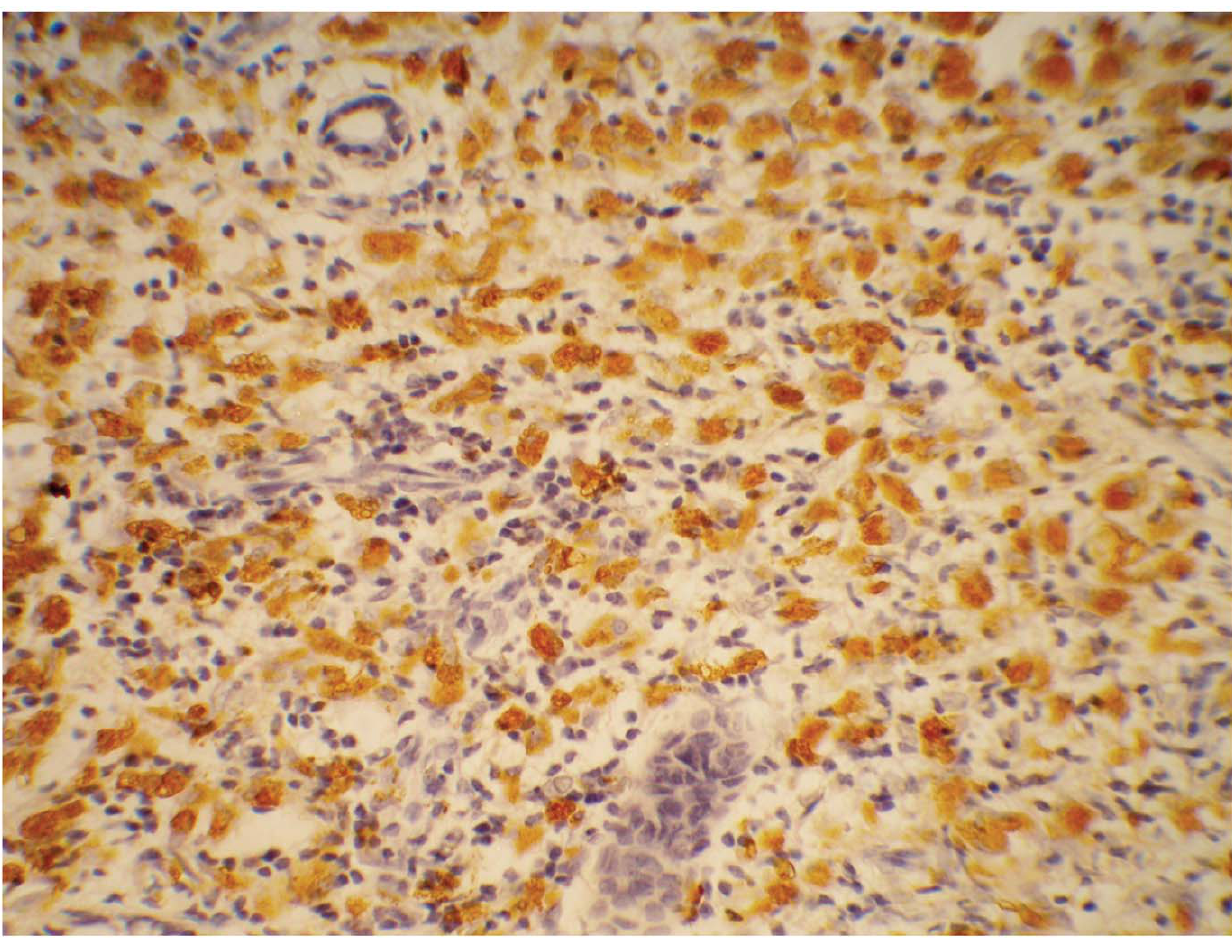
Figure 4. Skin showing CD68 cells. Skin showing CD68 positive macrophages. IHC staining 6 40.